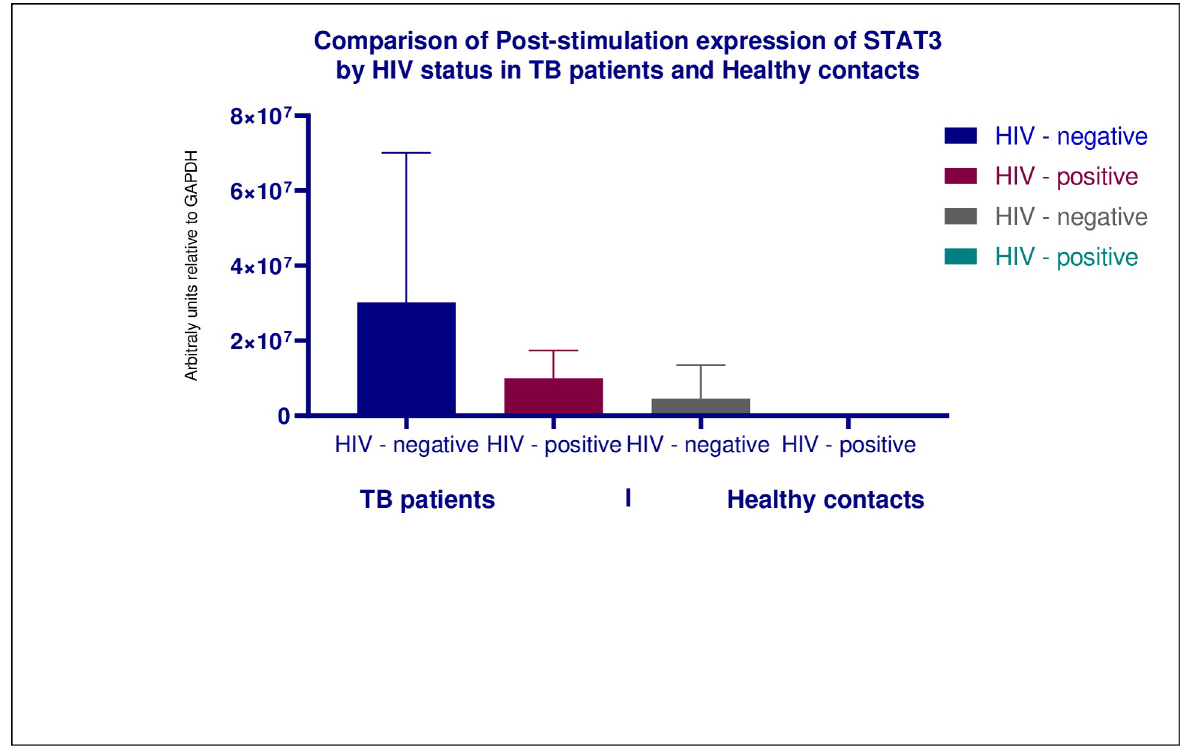
Fig 5. Shows column bar graph of the expression of STAT3 in TB patients vs healthy contacts stratified by HIV serostatus. We found no statistically significant difference in the expression of STAT3 between the categories of participants. Statistical significance was assessed using Kruskal–Wallis